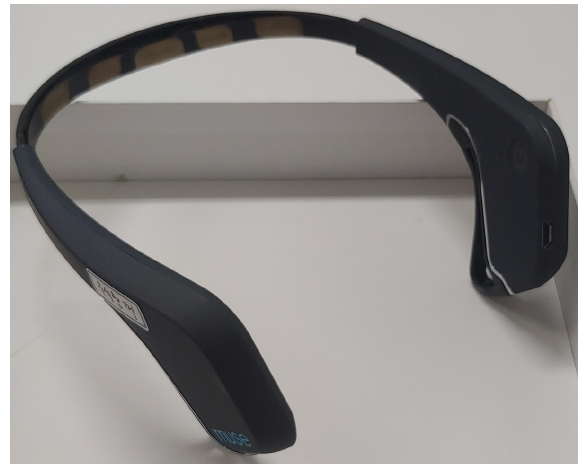
Figure 3. EEG sensor (Muse Brainband 2016